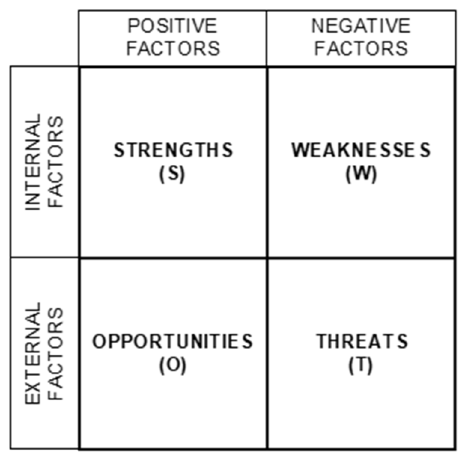
Figure 1. Traditional Strengths, Weaknesses, Opportunities, and Threats (SWOT) matrix [24].